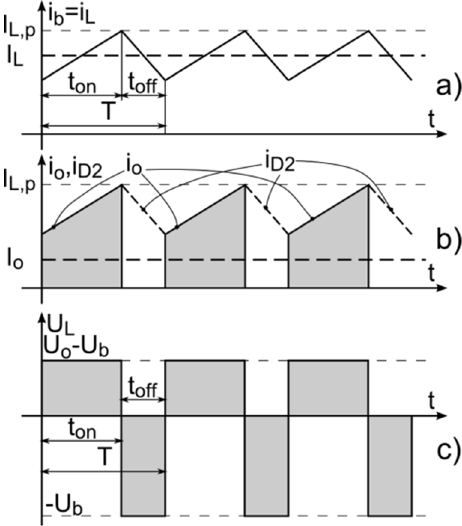
Figure 5. Layout 1 charge operation: current and voltage waveforms (continuous